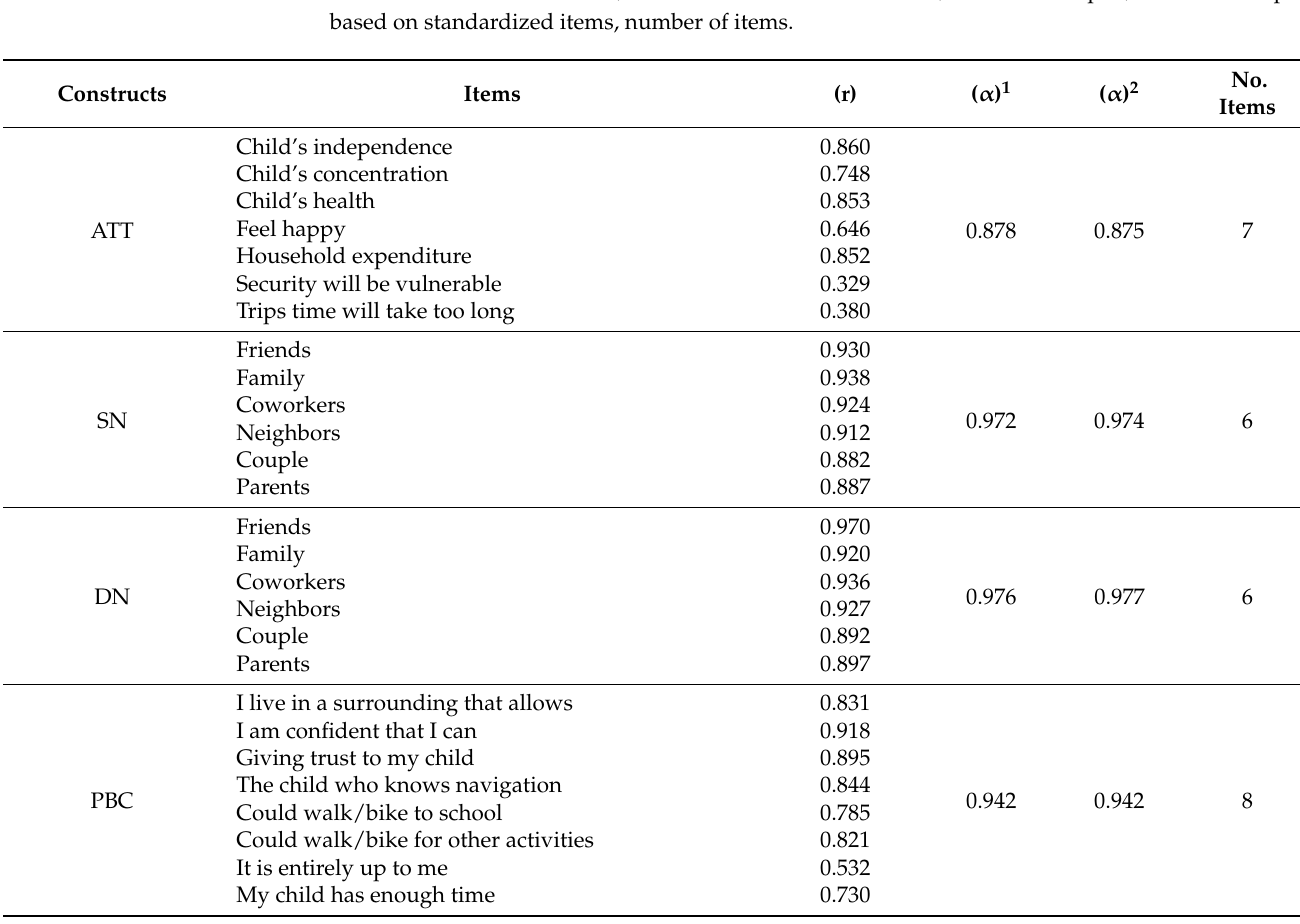
Table A2. Overview of items, corrected item-total correlation, Cronbach’s alpha, Cronbach’s alpha based on standardized items, number of